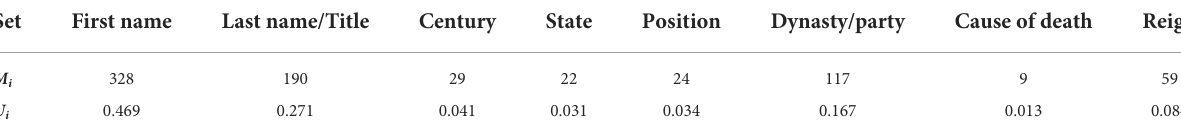
TABLE 1 Unique features and U-factors for sets in the EHoS dataset.